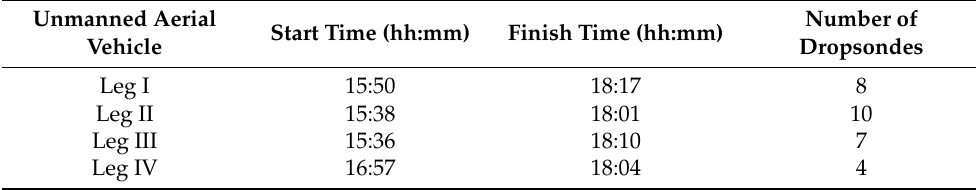
Figure 1. ( a ) Time-height cross-section for the two-way rawinsondes and UAV dropsondes launched during the South China Sea Experiment 2020 of the “Petrel Project”, designed to characterize the atmospheric environment of Typhoon Sinlaku (2020). The ascending, drifting, and descending stages are denoted by red, green, and blue color. The black line represents the dropsondes deployed by the UAV. The solid lines denote the observations used in this study. The lower left panel ( b ) shows the trajectory of a two-way rawinsonde during pre-TD, and the lower right panel ( c ) shows the track of UAV for flight leg III as listed in Table 2. Note that the time is in local standard time (UTC + 8 h). Table 2. The information on dropsonde measurements conducted from the unmanned aerial vehicle on 2 August 2020. Note that all times are in